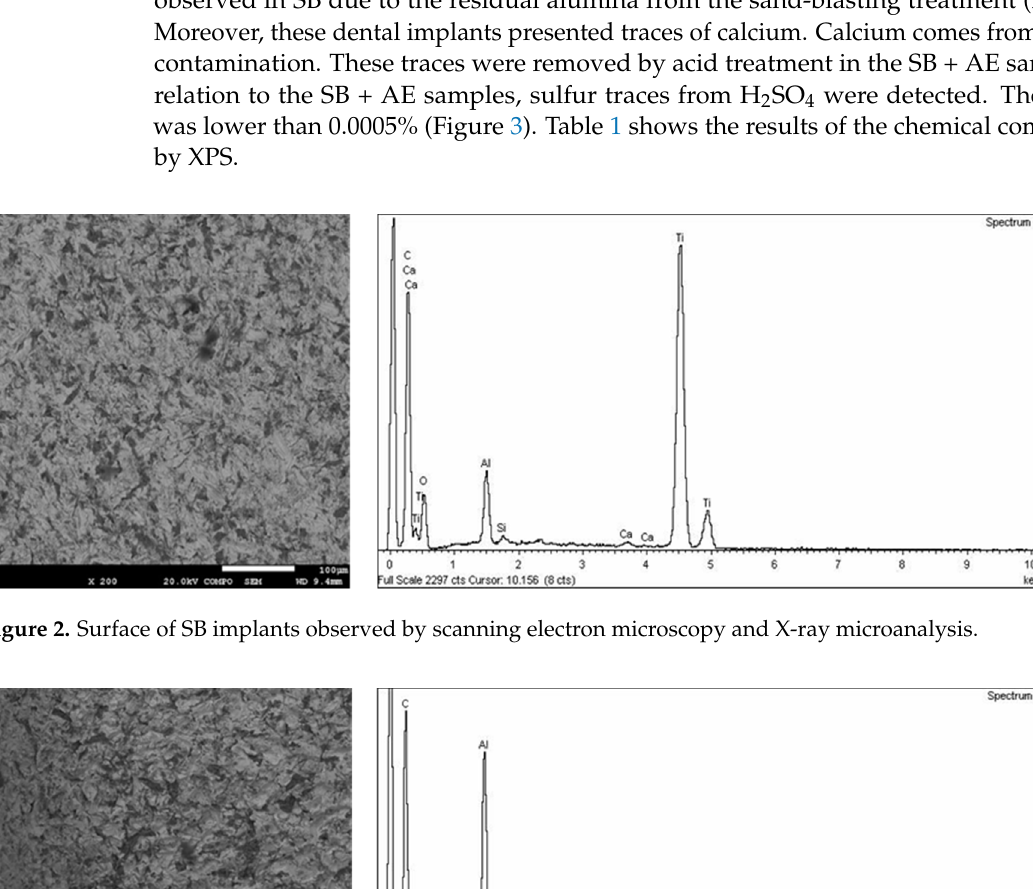
Coatings 2021 , 11 , x FOR PEER REVIEW